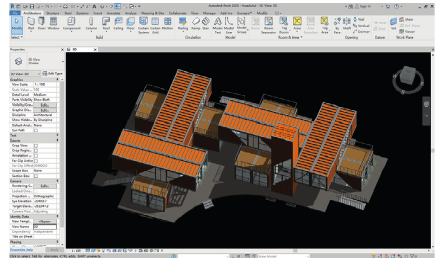
Figure 4: BIM model of the Tourist Service Center based on BIM platform (Autodesk